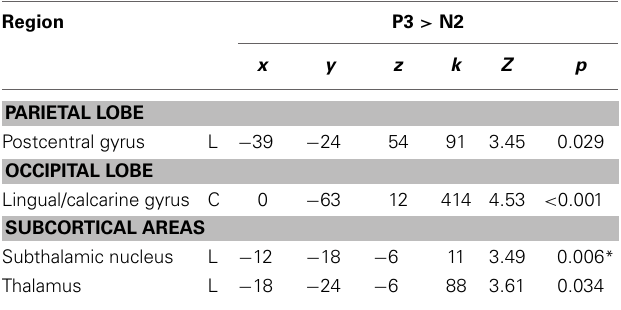
Table 4 | Brain regions significantly stronger correlated with P3 single-trial amplitude values (350–570ms after stimulus onset) than with N2 single-trial amplitude values (280–340ms after stimulus onset).